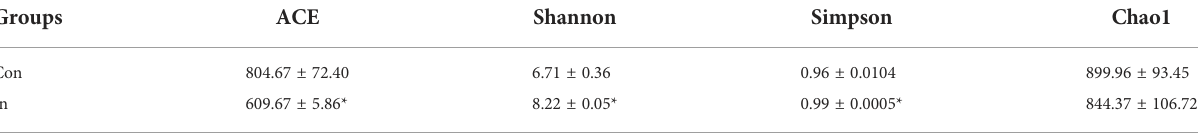
TABLE 2 Alpha diversity of intestinal microbiota of largemouth bass following MSRV infection.